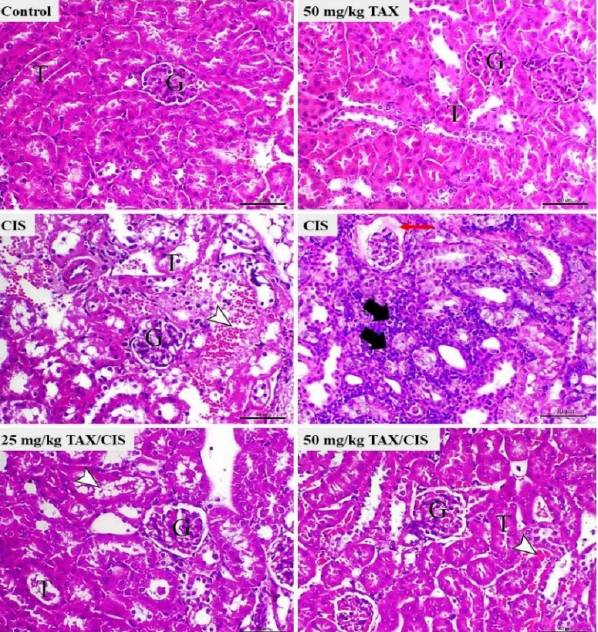
Figure 2. Photomicrographs of sections in the kidney of control and TAX-treated mice showing normal renal glomeruli (G) and tubules (T), CIS-intoxicated mice showing parenchymal haemorrhage (arrowhead) and a severe degree of vacuolar degnerative changes within the lining epithelium of the renal tubules, enlarged space around glomeruli (red arrow), and inflammatory cell infiltration (black arrow), CIS-administered mice treated with 25 mg/kg TAX showing a decrease in the vacuolar degenerative changes (arrowhead), and 50 mg/kg TAX, showing mild congestion of the renal blood cappillaries (arrowhead) and marked decrease in the degenerative changes within the lining epithelium of the renal tubules. (Hematoxylin and eosin (H & E), scale bar = 50 µm).